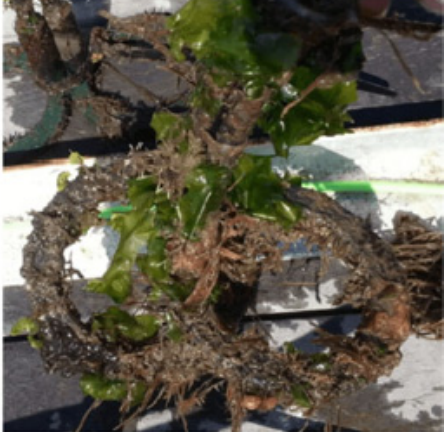
Figure 17. UWPT coil bottom after 45 days [115].